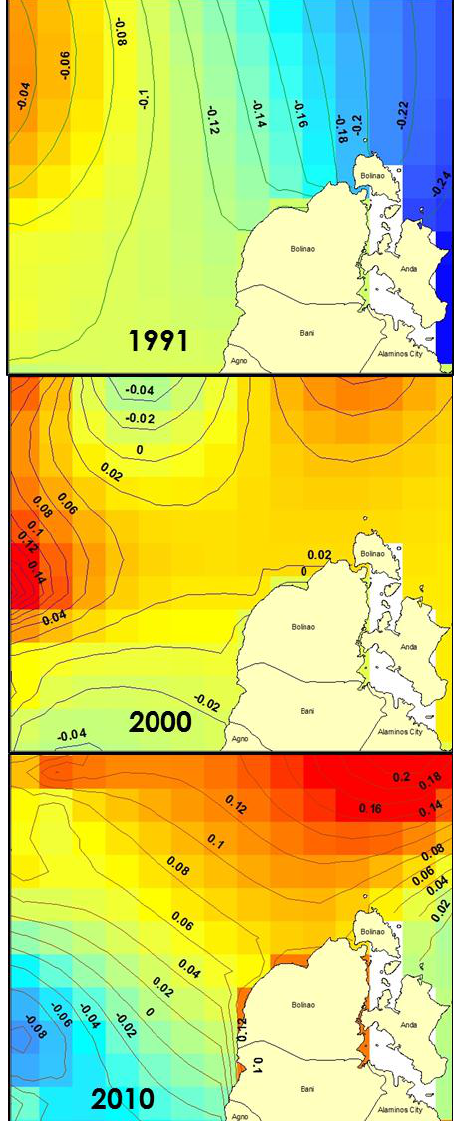
Figure 7. Contour maps of sea level anomalies for 1991 (top), 2000 (middle) and 2010 (bottom).